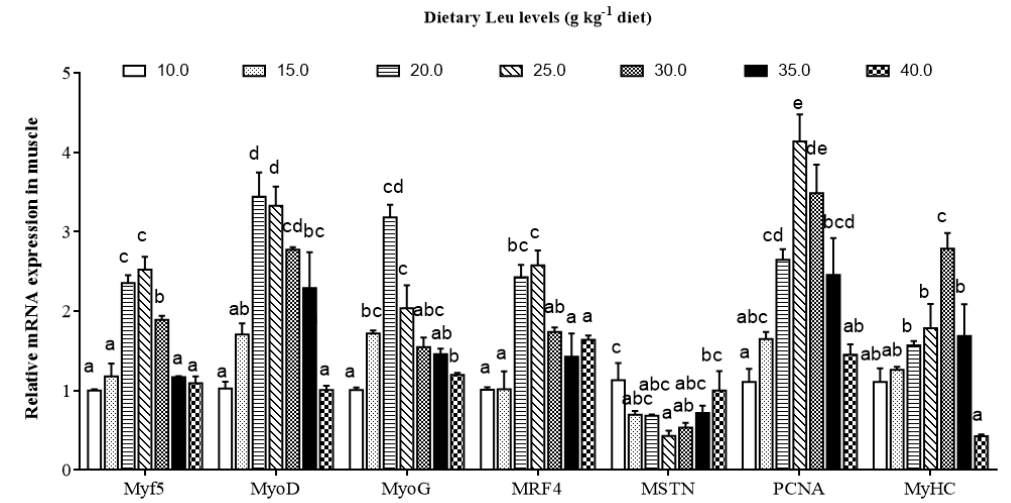
Figure 5. Effects of dietary Leu on muscle growth related gene mRNA expressions in muscle of hybrid catfish. Values are means ± SEM of three replicates, with six fish in each replicate, and different letters denote significant differences ( P <